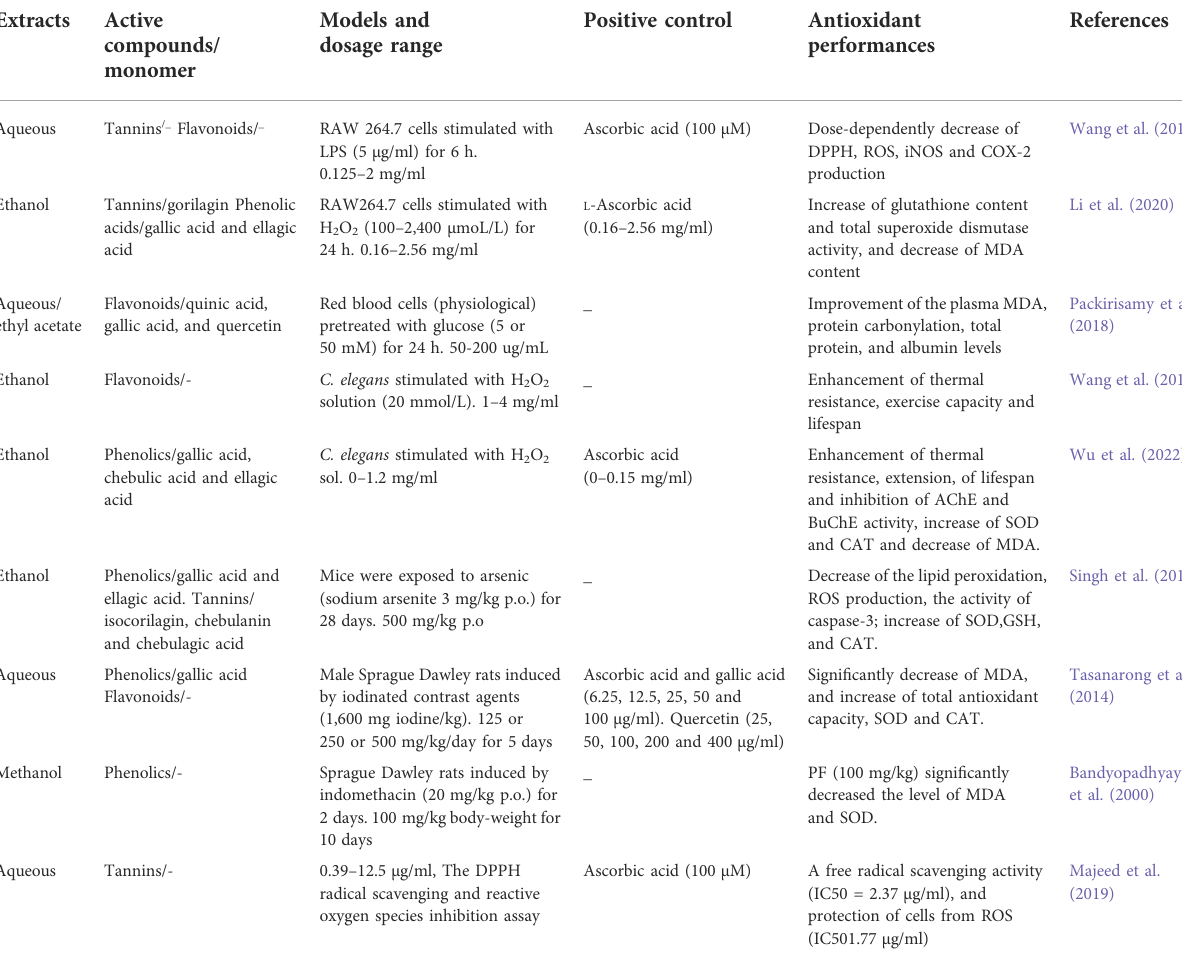
TABLE 2 Anti-oxidant active components of PF